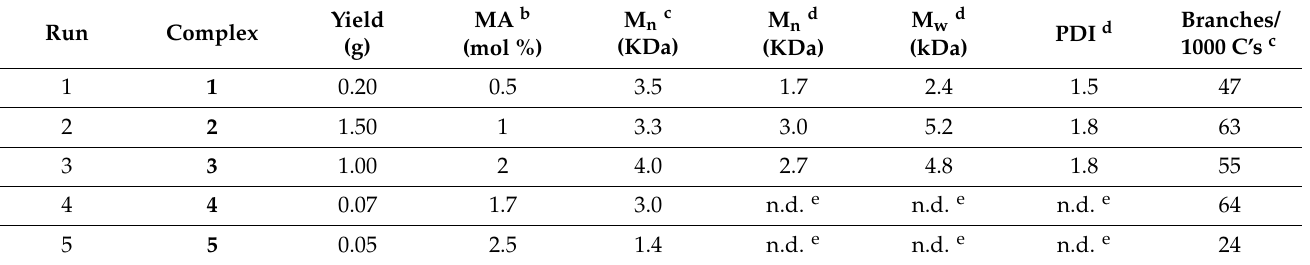
Table 1. Ethylene-Methyl Acrylate Copolymerizations by Complexes 1 – 5 under 6 atm of Ethylene a .